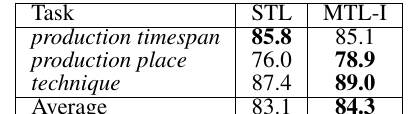
Table 5. F1-Scores [%] for the task technique (first series of experiments).